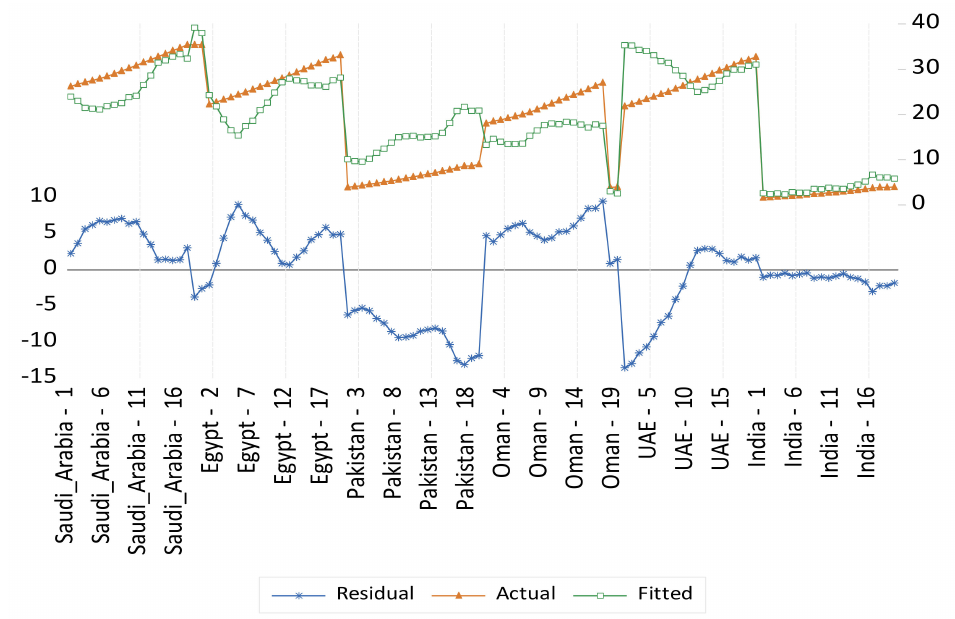
Figure 7. Actual, fitted, and residual of obesity in random-effect model. Panel fixed- and random-effect models for obesity results are presented in Table